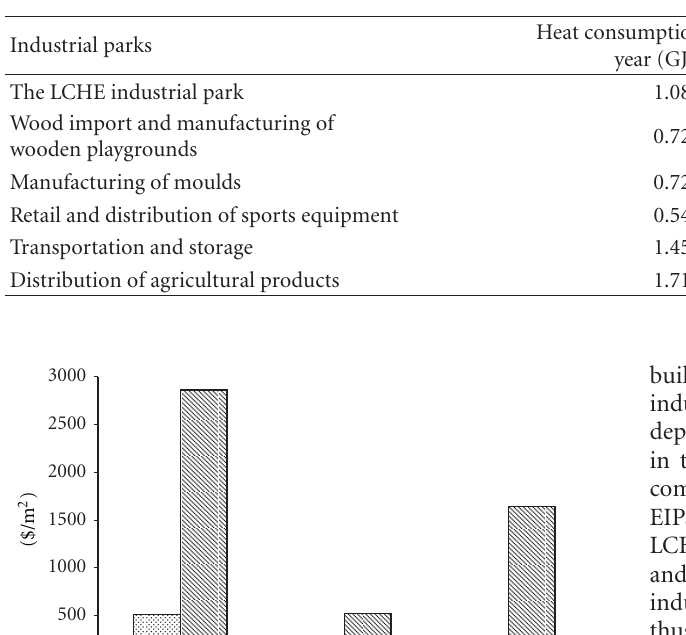
Table 2: Comparisons of heat and electricity consumption of di ff erent industrial parks [32].